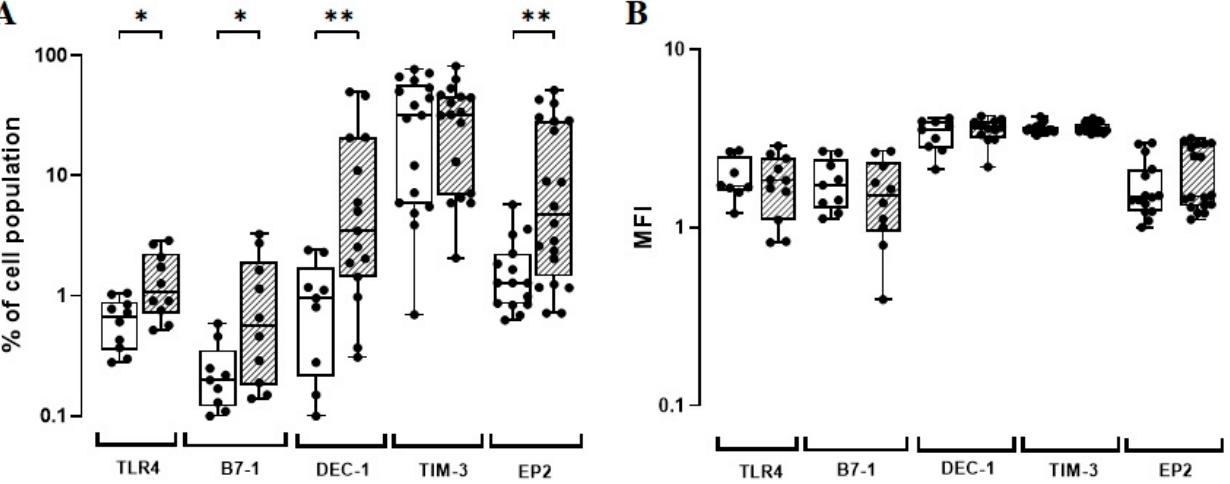
Figure 1. ( A ) TLR4, B7-1, DEC-1, TIM-3, and EP2-phenotypic marker expression levels (%) induced in vitro by BCG Moreau (hatched) and baseline (opened) at 72 h (EP2) or 48 h (others) on human mononuclears from adult healthy donors (HD; n = 17). Box and whisker plots denote the median and interquartile range phenotypic marker expression values in each condition. * p ≤ 0.05; ** p < 0.01. ( B ) The same as ( A ), except for the phenotypic marker intensity (MFI) induced under similar conditions.